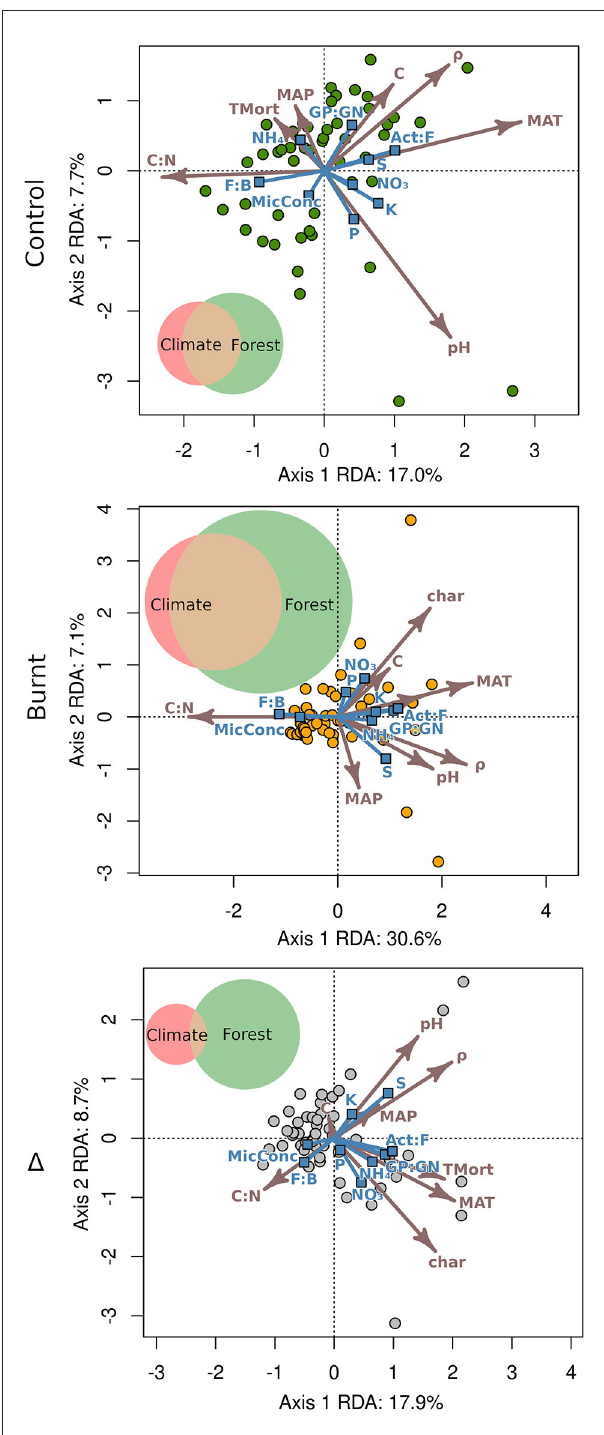
FIGURE4 Redundancy analysis triplots with explanatory vectors (arrows) scaled by 3 for legibility. Predicted variables are marked by vectors ending in blue squares and plot scores by circles. Variance partitioning is visualized for each chart with relative area of climate (MAT, MAP), forest (all other explanatory variables), and their overlap proportioned across plots to their magnitude of R 2 adj for control (climate: 0.041, forest: 0.098, shared: 0.082, total: 0.221), burnt (climate: 0.033, forest: 0.181, shared: 0.153, total: 368), and 1 (climate: 0.053, forest: 0.201, shared: 0.013, total: 267)